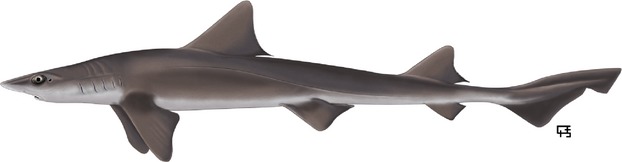
Mustelus henlei.